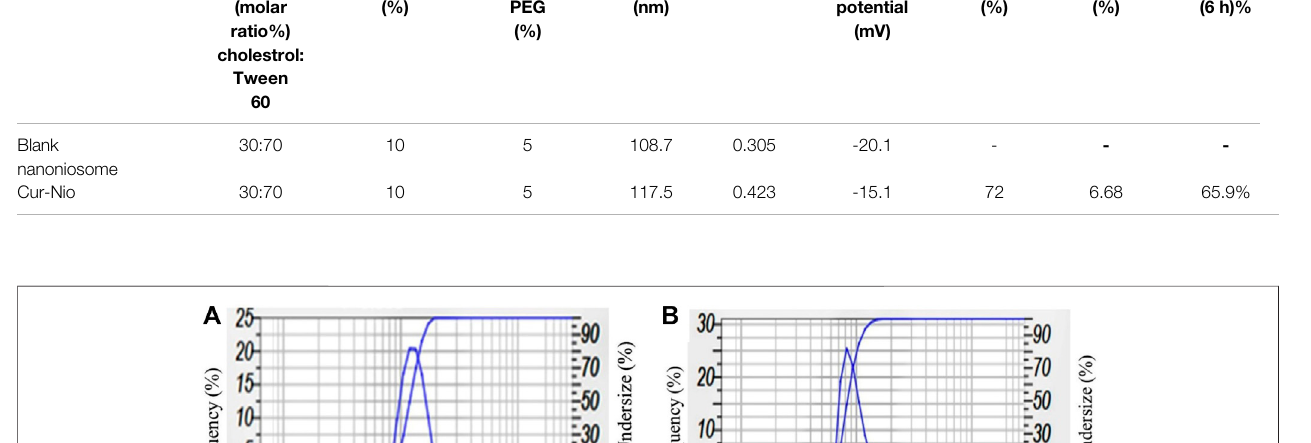
TABLE 1 | Characterization of blank nanoniosomes and Cur-Nio. Formula